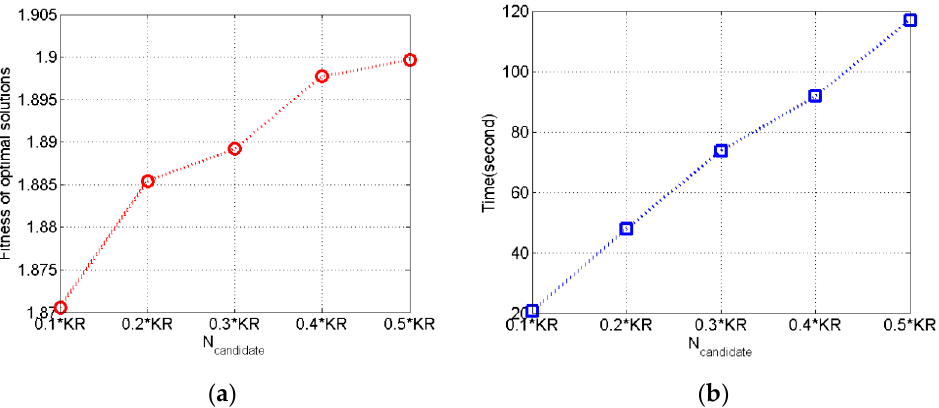
Figure 9. Performance comparison of EVNS under different values of N candidate : ( a ) Fitness of optimal solutions; ( b ) Running time.